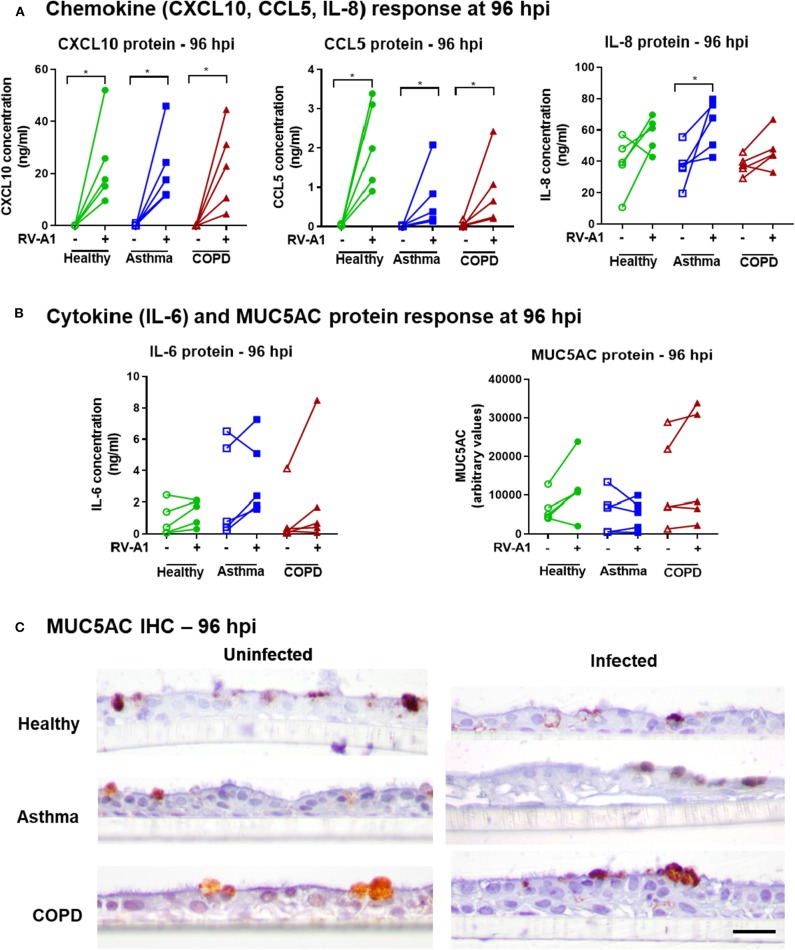
Chemokine, cytokine and MUC5AC responses in differentiated BECs following RV-A1 infection. Quantification of chemokines (CXCL10, CCL5, IL-8) (A), cytokine (IL-6) and MUC5AC (B) protein levels in apical culture supernatants from BECs at 96 hpi. CXCL10, CCL5, and IL-6 were quantified by cytometric bead array and IL-8 and MUC5AC by ELISA. Cellular MUC5AC protein visualized by staining with anti-MUC5AC antibody (C), Scale bar: 25 μm. Biological replicates are represented as individual points (n = 5) and analyzed using Wilcoxon signed-rank test within the group (*p < 0.05) and between groups using Kruskal-Wallis test.